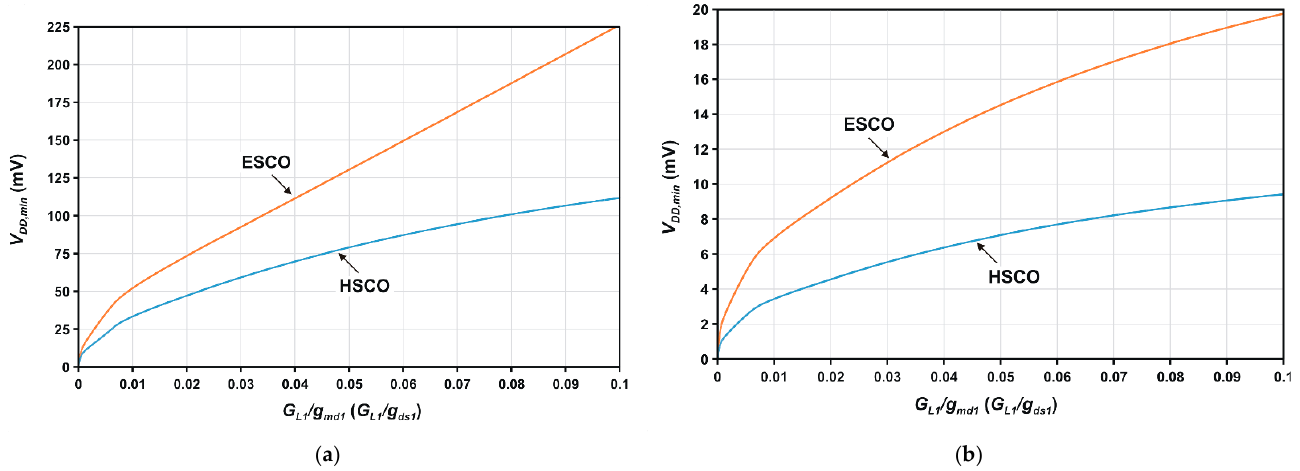
Figure 3. The minimum supply voltage, V DD,min , required to start oscillations in ESCO and HSCO as a function of G L 1 / g md 1 ( G L 1 / g ds 1 ), for the transistor operating in: ( a ) the strong inversion region; ( b ) the weak inversion region.